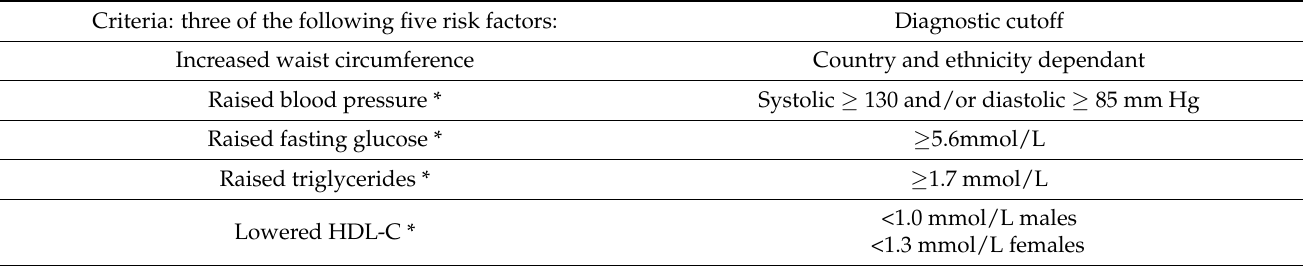
Table 1. Harmonized criteria for the clinical diagnosis of metabolic syndrome (Adapted from [7]). Criteria: three of the following five risk